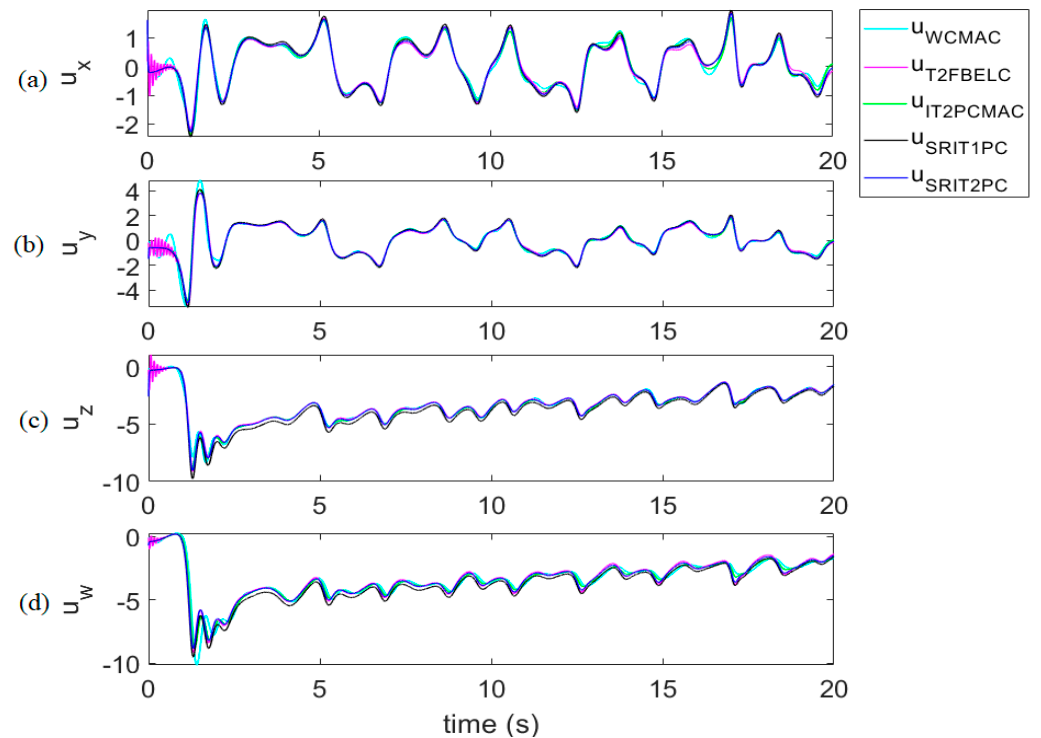
Figure 24. Control signals between the proposed SRIT2PC and other synchronization methods for Case 4: ( a ) u x , ( b ) u y , ( c ) u z , and ( d ) u w .